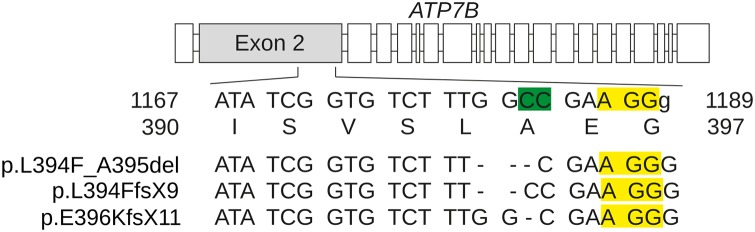
CRISPR/Cas9 target sequence for knockout of ATP7B.The nucleotide sequence of the CRISPR sgRNA that targets exon 2 of ATP7B is given in capital letters. The putative Cas9 cleavage site (green) and the PAM motif (yellow) are depicted. The amino acid sequence is also represented. Numbers refer to nucleotide and amino acid positions of ATP7B. The three compound deletions observed in the KO cell line are depicted.